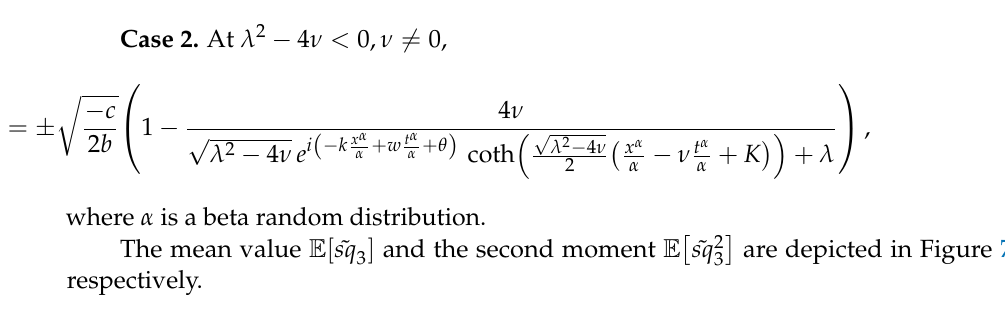
in (54); α is a beta random variable 1 (cid:3) are depicted in Figure 7a,b, 3